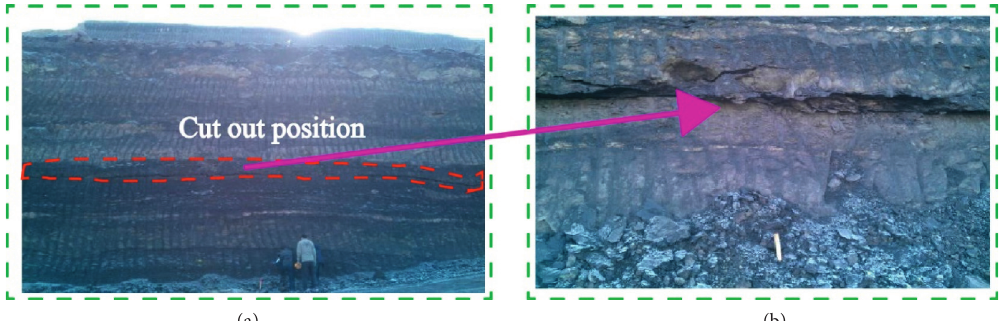
Figure 16: Shear deformation of the slope. (a) Slide shear outlet. (b) Locally enlarged